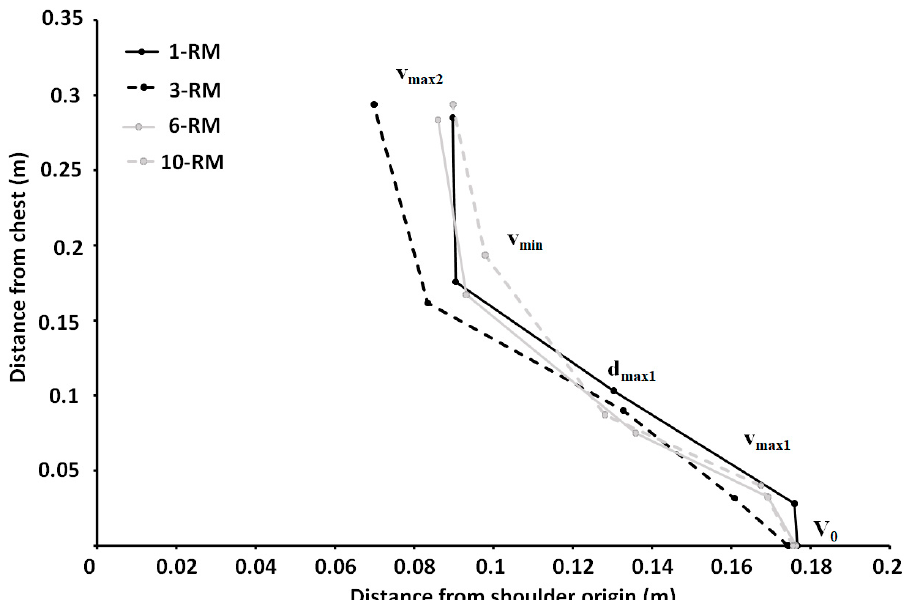
Figure 1. Mean distance in meters from the chest is shown on the y-axis and the distance from the shoulder origin on the x-axis for the 1-RM, 3-RM, 6-RM, and 10-RM in the bench press for the events v 0 , v max1 , d max1 , v min and v max2 . No significant differences were found between the conditions for shoulder flexion, shoulder abduction or elbow extension angles in any of the events (F ≤ 2.8, p ≥ 0.058, η p2 ≤ 0.24, Figure 2).